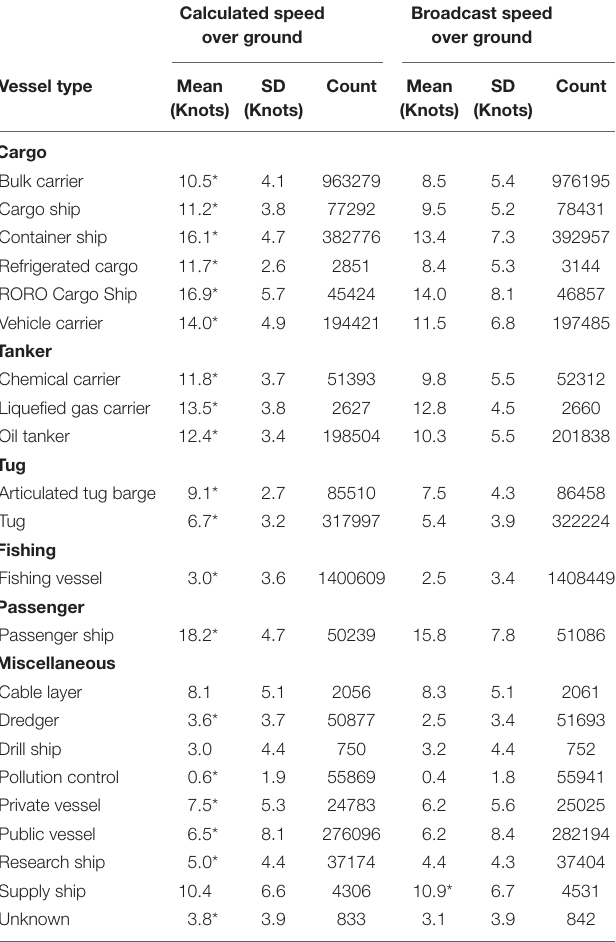
TABLE 2 | Overall calculated and broadcast speed over ground (SOG) by vessel type for 2013 and 2014 combined. Calculated speed Broadcast speed over ground over